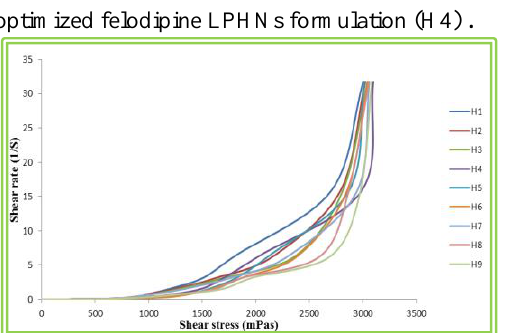
Figure 1. Shear stress against the shear rate of felodipine LPHNs formulations (H1-H9). Table 3. The shear stress results at different shear rates of felodipine LPHNs formulations (H1-H9) Shear stress* Shear